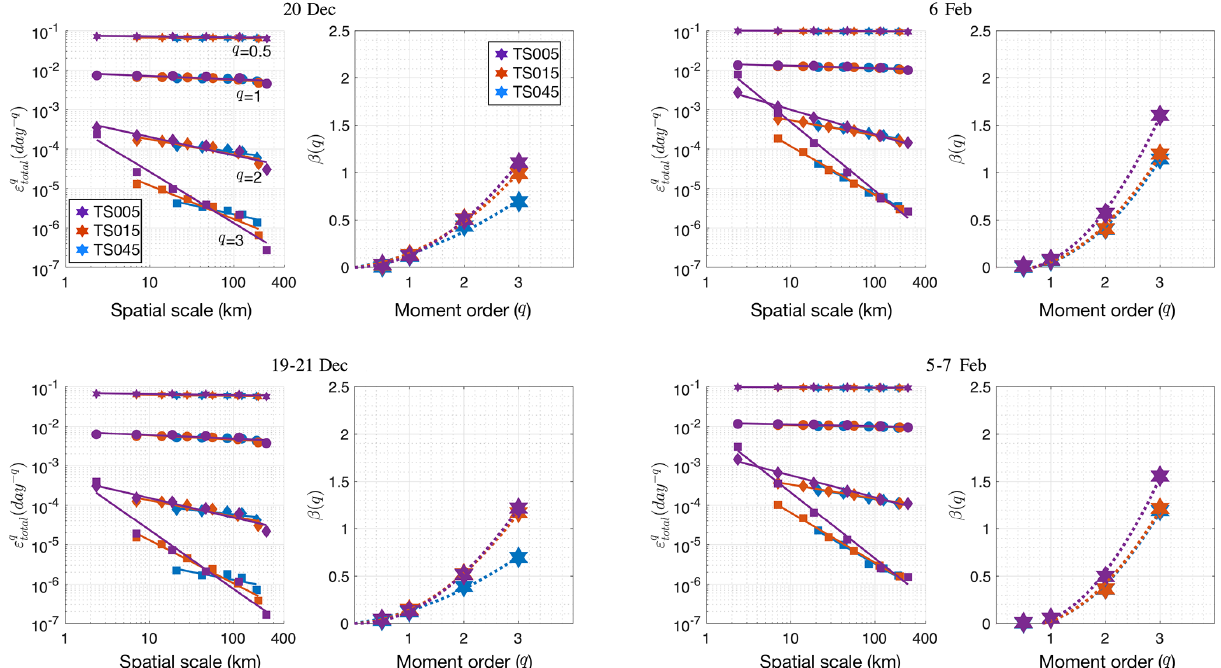
Figure 10. Spatial scaling of total deformation rate for daily deformation fields (top row) and 3d mean deformation fields (lower row). The daily mean velocity fields on 20 December and 6 February, as well as the 3d mean velocity fields centering on 20 December and 6 February, are used to derive the scaling curves. Each panel contains the scaling curves and the structure function relating the scaling coefficients ( β ) to the moment of order ( q ). Similarly to Figs. 7, 8, and 9, the results are based on experiments with NDTE = 960. The detailed methodology used to compute the deformation rates with the model outputs is outlined in Appendix B.